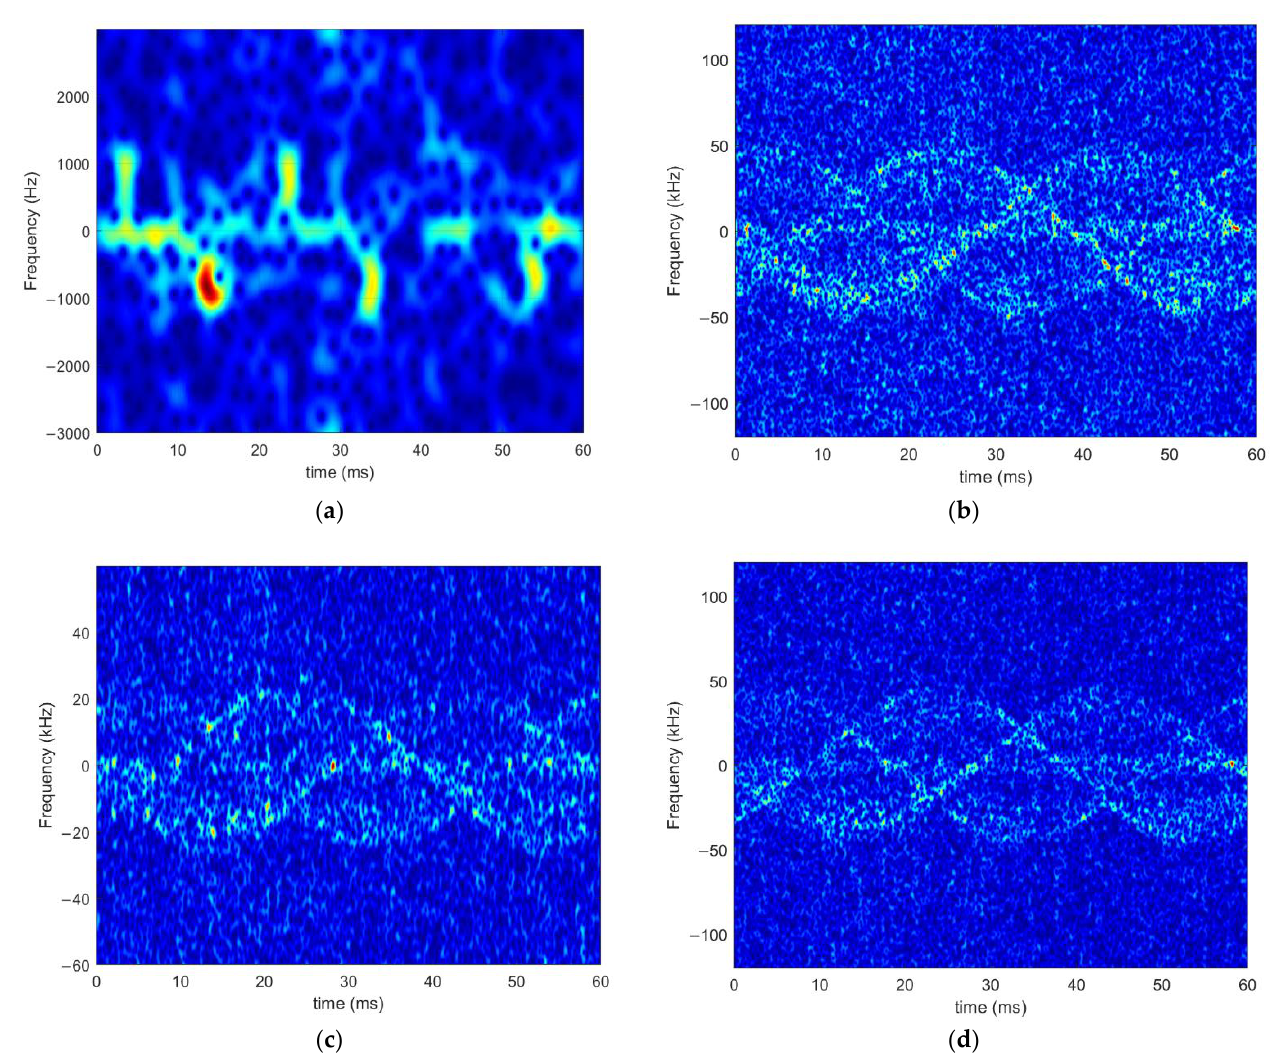
Figure 7. Simulation results of three frequency bands for the three-bladed turbine: ( a ) The simulation result of A. ( b ) The simulation result of B. ( c ) The simulation result of C. ( d ) The simulation result of D.